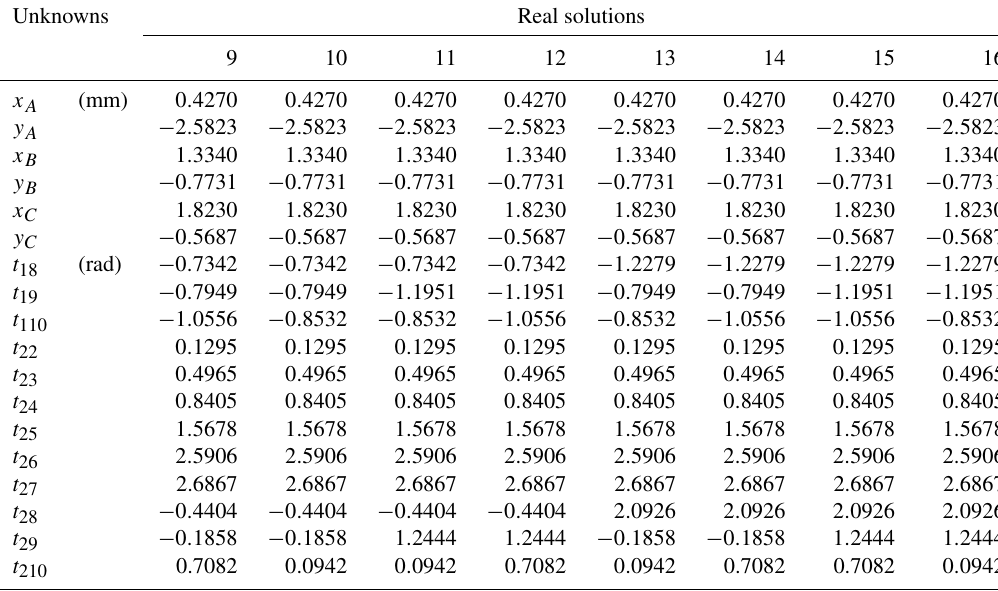
Table A5. Real solutions 9–16.